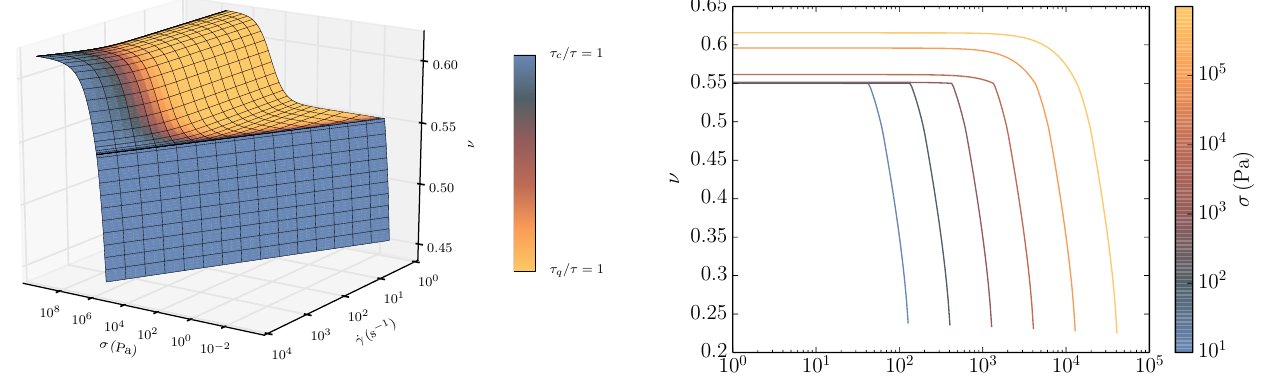
Figure 3. Critical state surface in the σ – ˙ γ – ν space. The color marks the origin of stresses: in yellow areas frictional stresses are domi- nant and in blue areas collisional stresses.